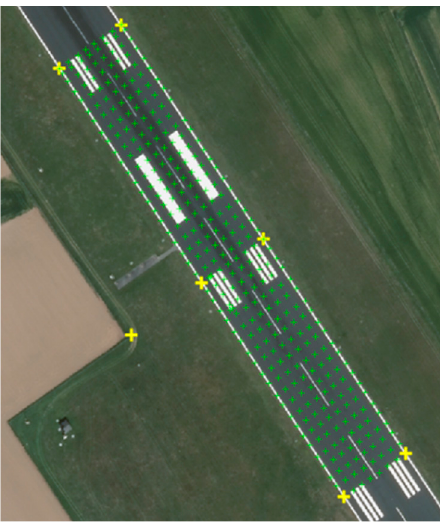
Figure 5. Basic geodetic net (yellow crosses) and recorded points for the comparative plane (green crosses).